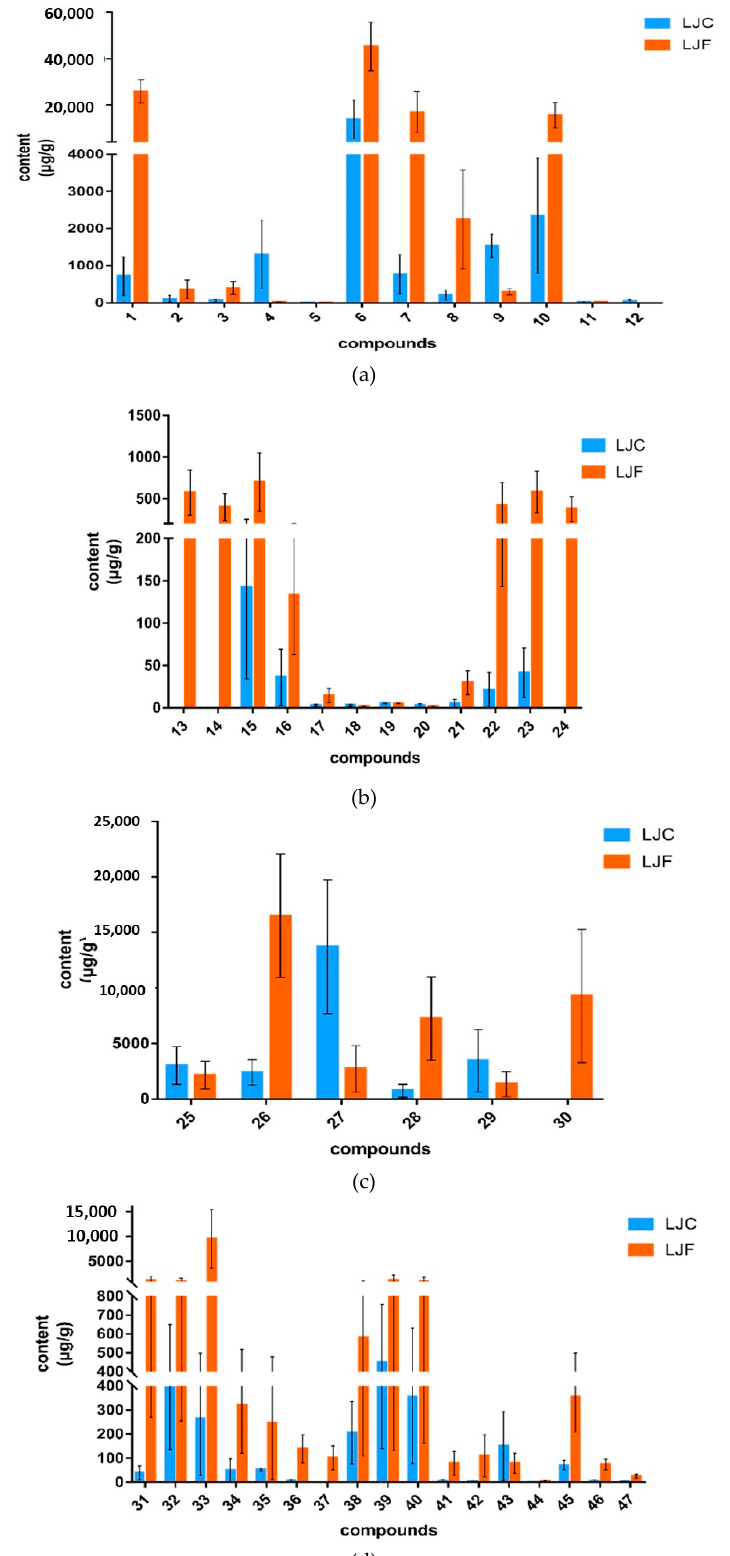
Figure 4. The contents of 47 compounds in samples. ( a ) organic acids, ( b ) flavonoids, ( c ) iridoids, ( d ) amino acids and nucleosides (X-axis 1–47 is the number of compounds, see Table 1 for compound names; Y-axis is the content ( μ g of compound/g)).